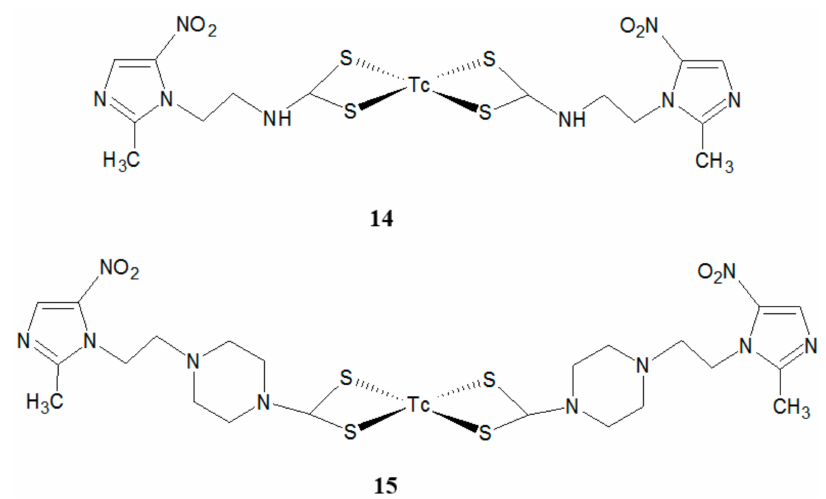
Figure 7. The structures of two new 99m Tc complexes ( 14 , 15 ).